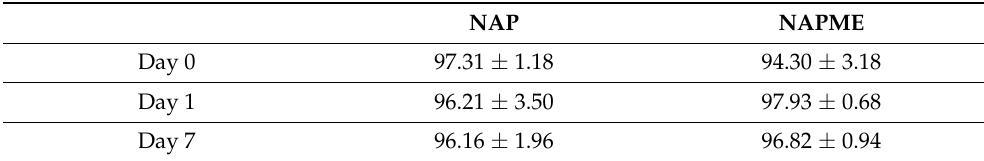
Figure 2. mDSC thermograms of ( A ) NAP spray dried from MeOH and ( B ) NAPME spray dried from MeOH, right after spray drying (black), after one day (red) and after one week (blue) of storage, and the mDSC thermogram of pure NAP and NAPME (green) as comparison. Total heat flow (THF) signals are shown as arbitrary units. Table 1. Average crystallinity percentages (%) for NAP and NAPME spray dried from MeOH ± standard deviation